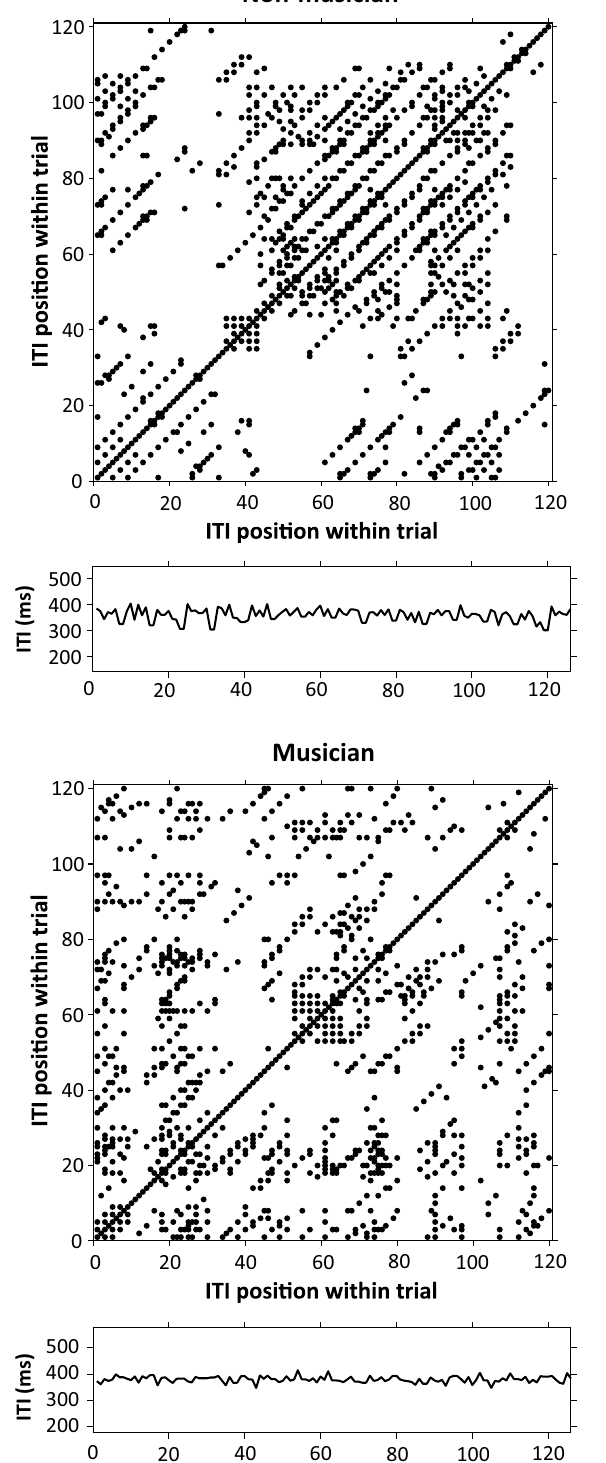
Figure 5. Recurrence plots demonstrating determinism for sample trials (intertap intervals) of Solo spontaneous production rates. X- and y-axes indicate ITI time series. Top: Non-musician: determinism (represented by % of points falling on diagonal lines) = .1842. Bottom: Musician: determinism =